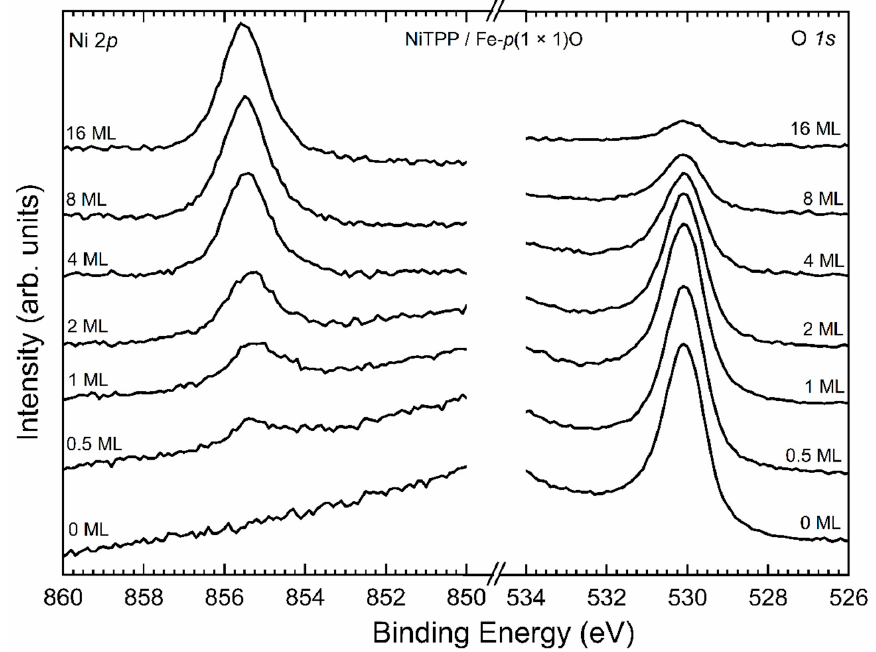
Figure 2. XPS spectra acquired with Mg K α emission line ( h ν = 1253.6 eV) in the Ni 2 p (left) and O 1 s (right) regions for the system NiTPP/Fe– p (1 × 1)O. The spectra are displayed from bottom to top with growing thickness of the NiTPP layer.